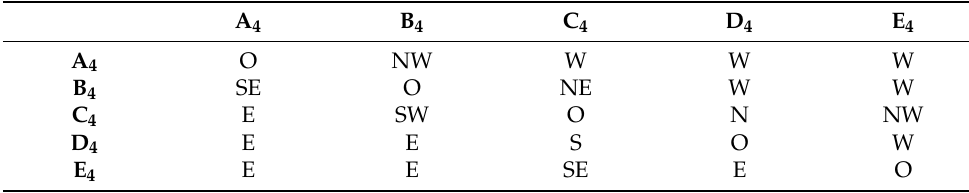
Table 17. Direction relations in the database scene (d) in Figure